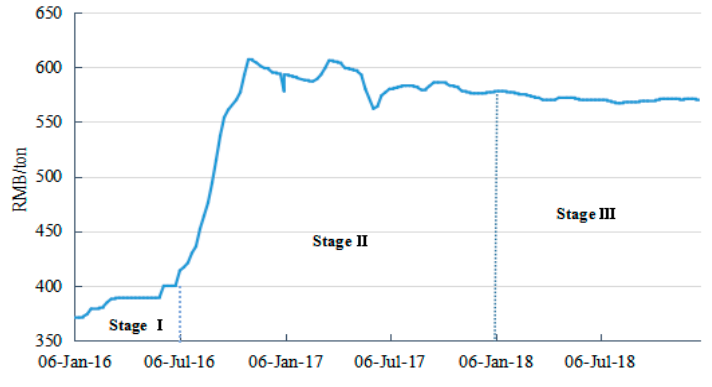
Figure 5. Bohai-Rim Steam-Coal Price Index (BSPI). Data source: [50].